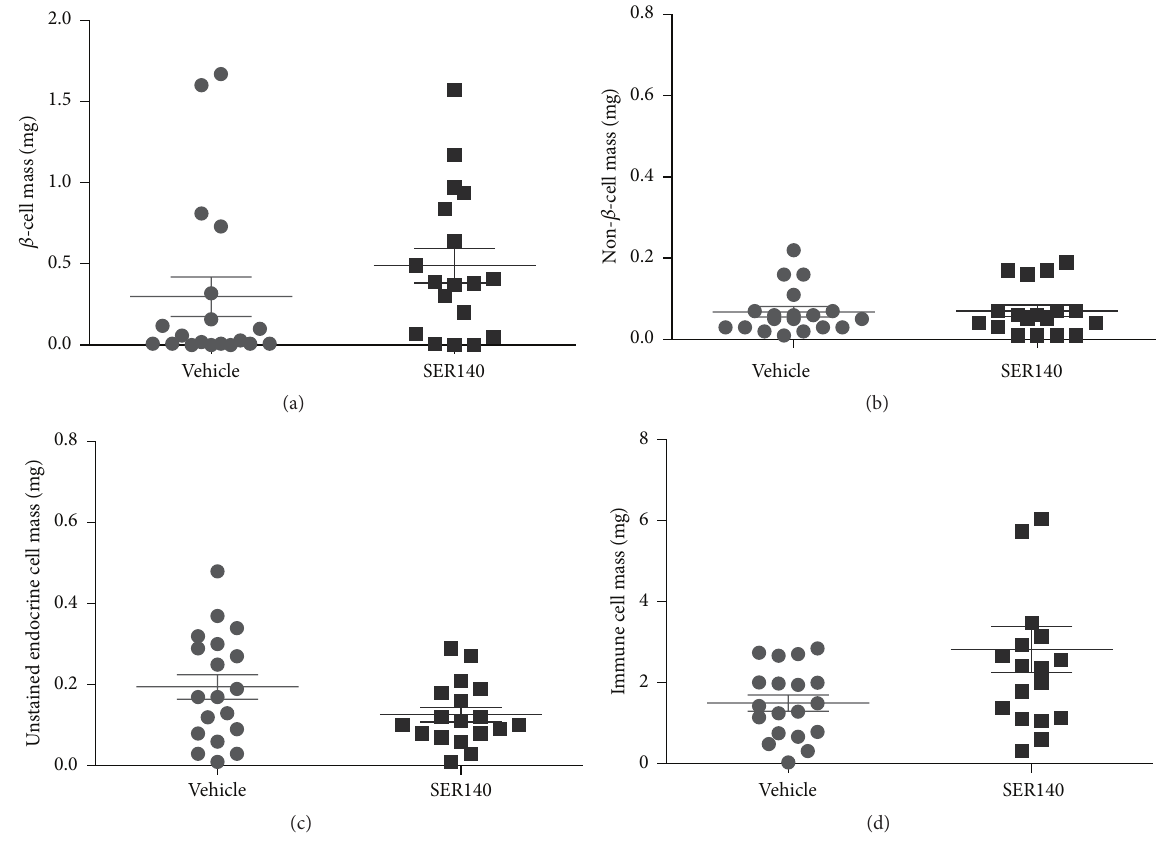
Figure 4: Stereological analyses of NOD mice pancreata. (a) 𝛽 -cell mass, (b) non- 𝛽 -cell mass, (c) unstained endocrine cell mass, and (d) immune cell mass in vehicle and SER140 treated NOD mice. The average for each group is marked by horizontal lines ( 𝑛 =